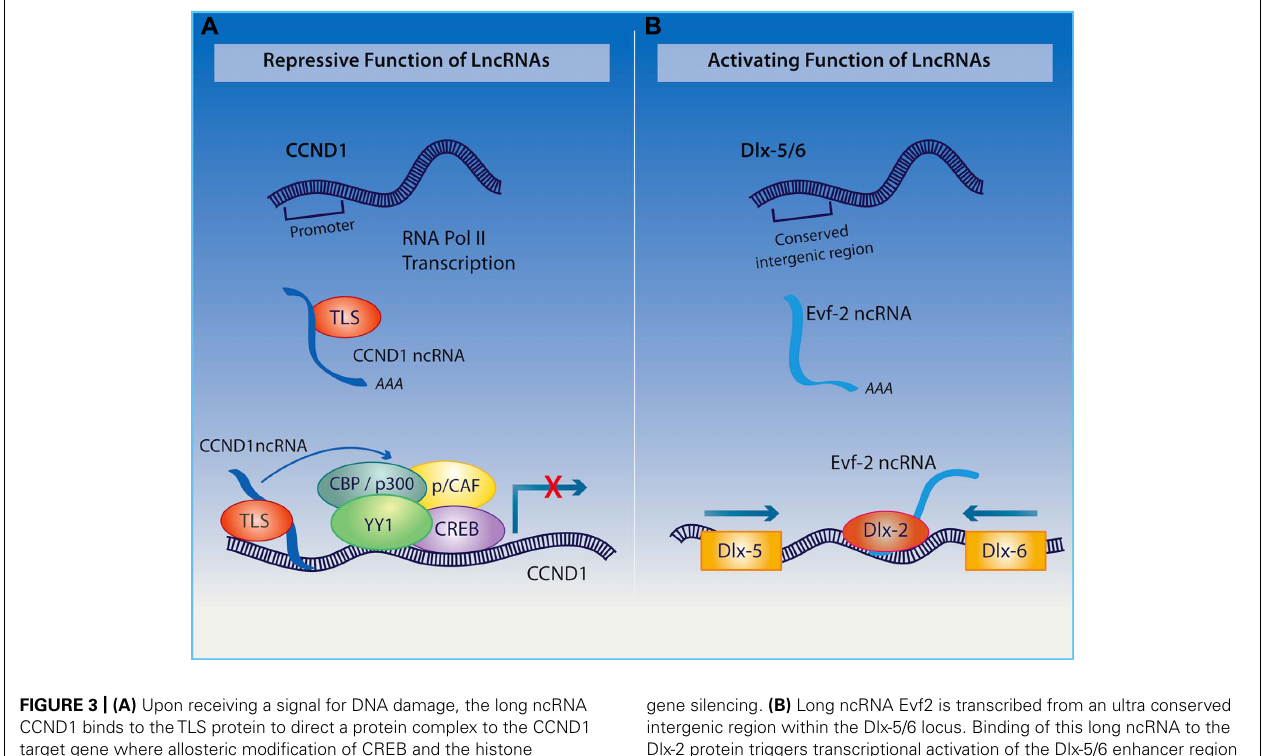
gene silencing. (B) Long ncRNA Evf2 is transcribed from an ultra conserved intergenic region within the Dlx-5/6 locus. Binding of this long ncRNA to the Dlx-2 protein triggers transcriptional activation of the Dlx-5/6 enhancer region in a homeodomain-specific manner.